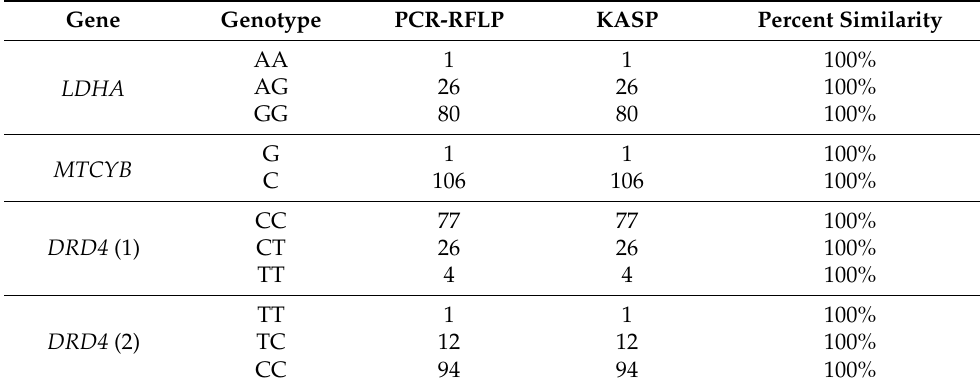
Figure 3. Representative results for DRD4 (1) gene SNP genotyping by PCR-RFLP and KASP assays. ( a ) Agarose gel electrophoretic profile of selected samples showing the banding patterns for the undigested PCR amplicon (lane 1), the TT allele (lane 2), TC allele (lane 3), and CC allele (lane 4) ( b ) Cluster plot for the KASP genotyping assay: TT allele (blue cluster), TC allele (green cluster), and CC allele (red cluster). Table 3. Summary of results for the genotype obtained using PCR-RFLP and